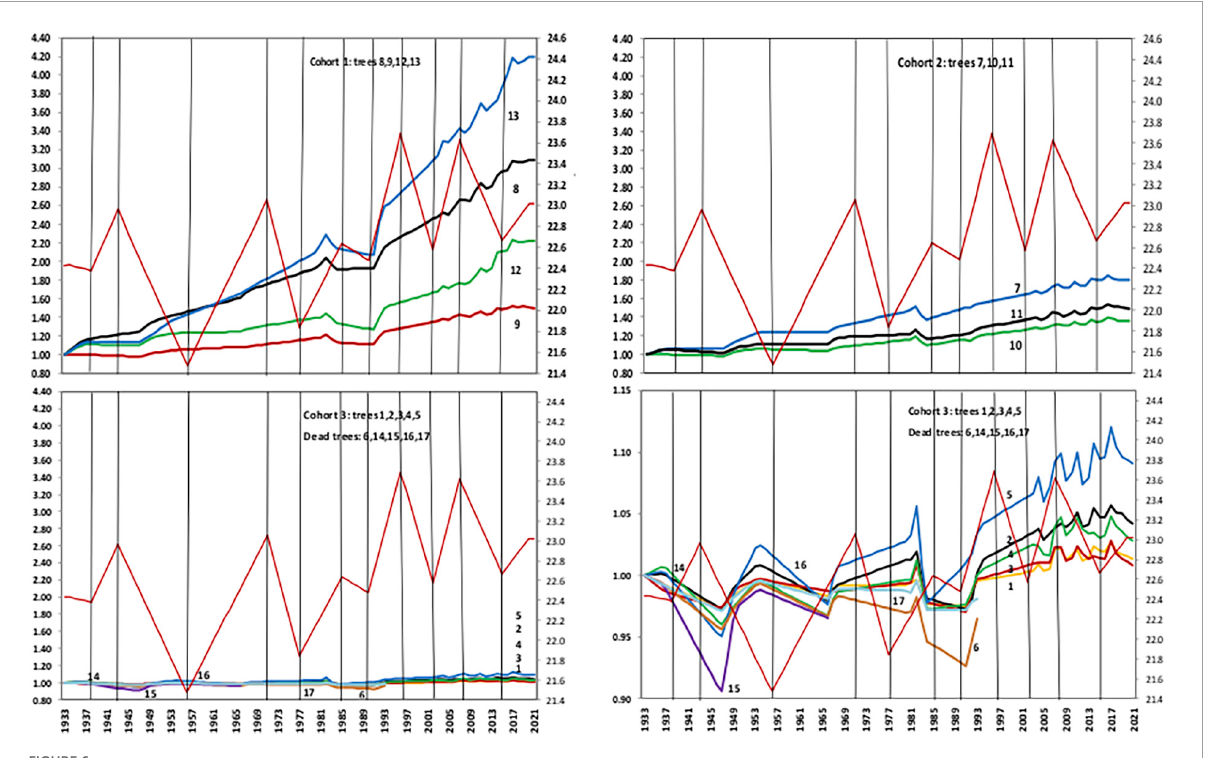
FIGURE6 Growth response to MAT and warming (red graphs) with dips in dry years between 1933 and